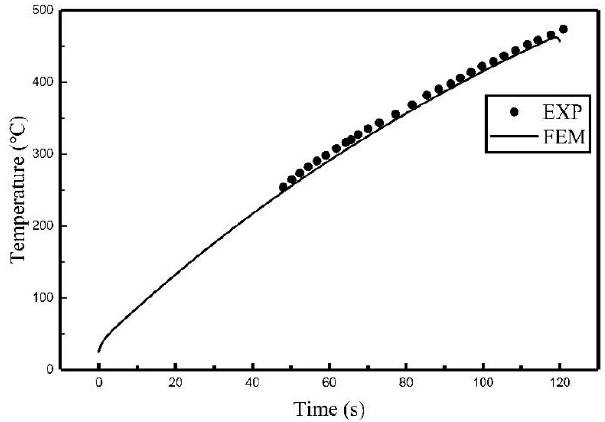
Figure 8. Comparison of the temperature histories of C 2 .